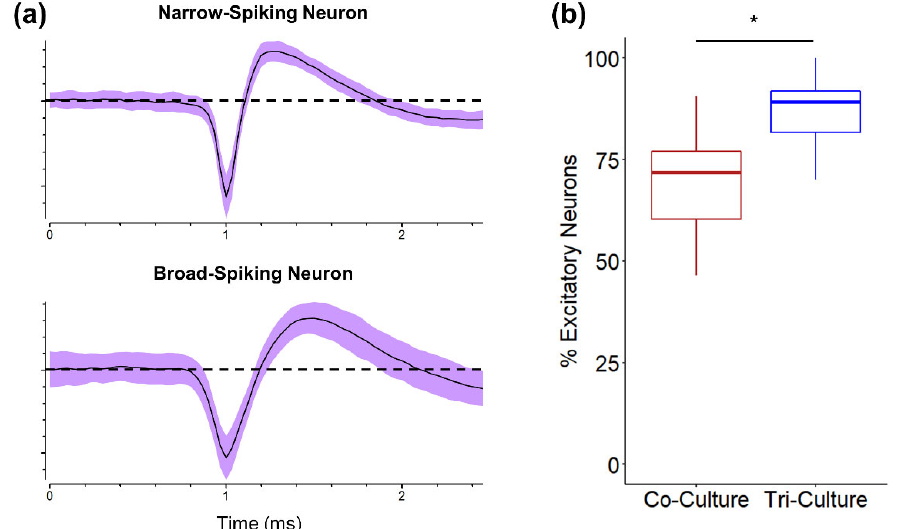
Figure 4. Comparison of the E/I ratio in tri- and co-cultures at DIV 21. ( a ) Representative waveforms of narrow-spiking and broad-spiking neurons recorded at DIV 21. The line represents the average spike waveform, while the shaded region is one standard deviation. ( b ) Percent excitatory neurons in the tri- and co-cultures at DIV 21 (n = 8 MEAs (249 total units) from three independent dissections). * p < 0.05.